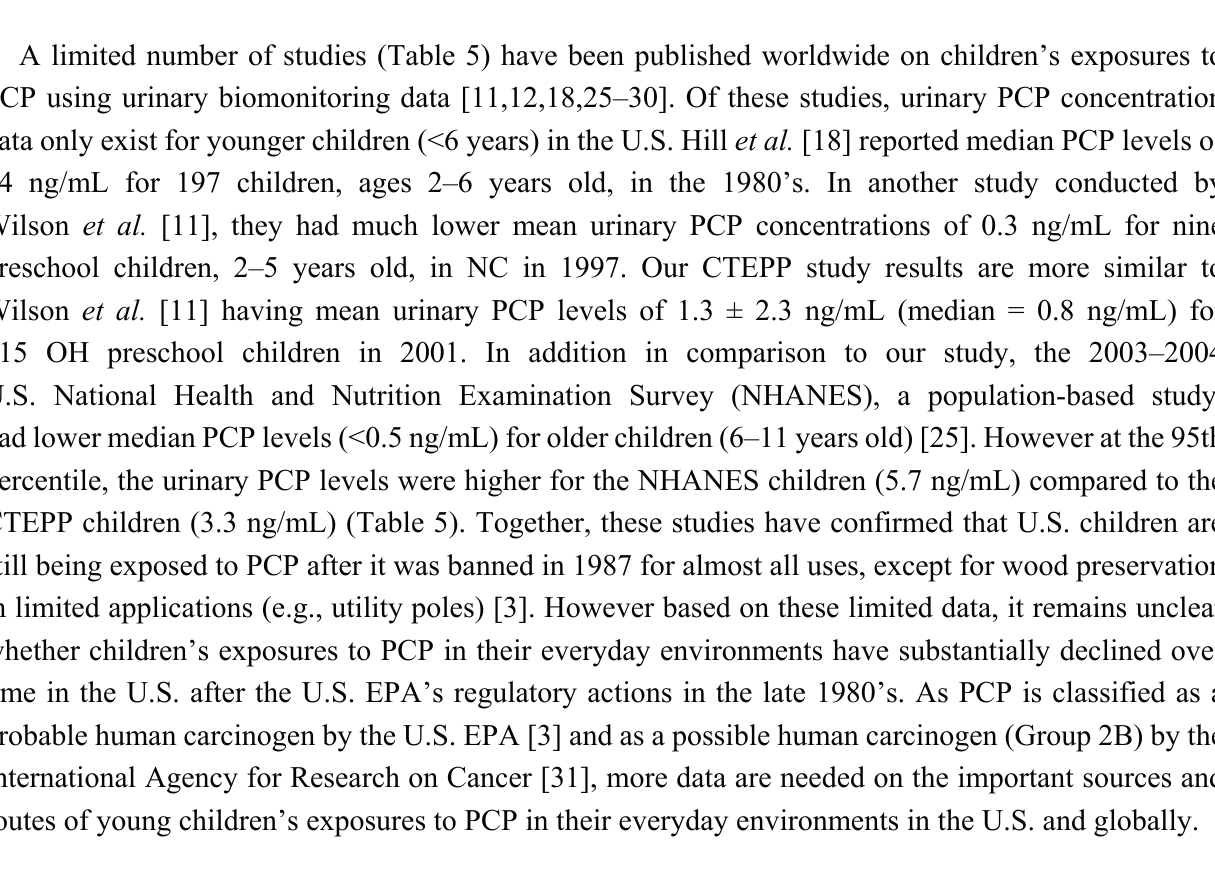
Table 5. Urinary PCP levels (ng/mL) in young children from published studies worldwide a,b .